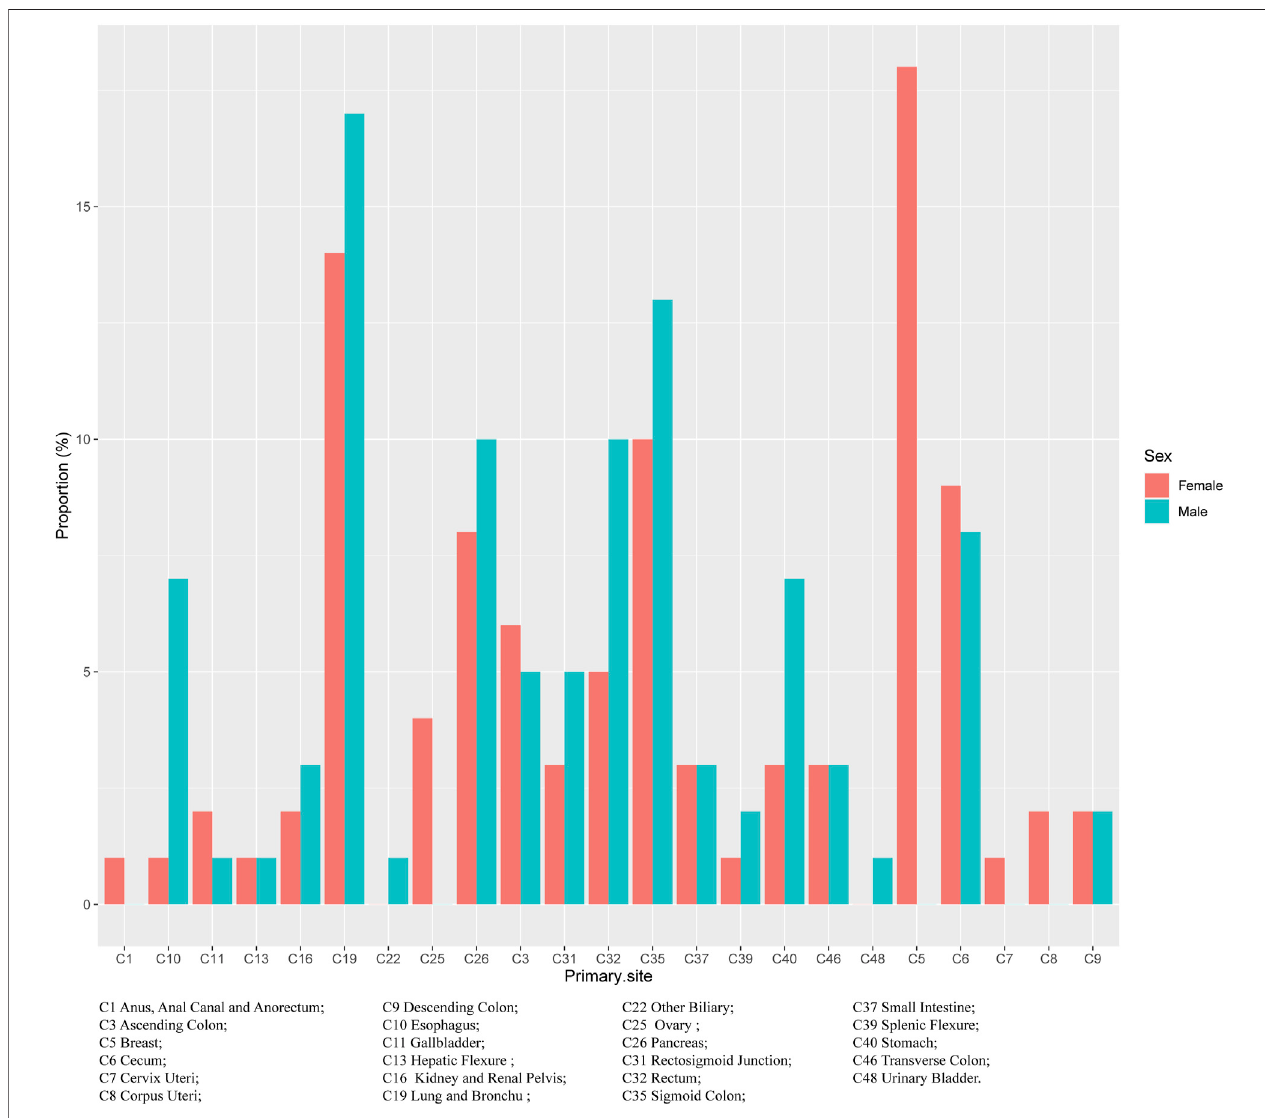
FIGURE 3 | The purpose of primary tumour sources of liver metastatic carcinoma in both sexes.